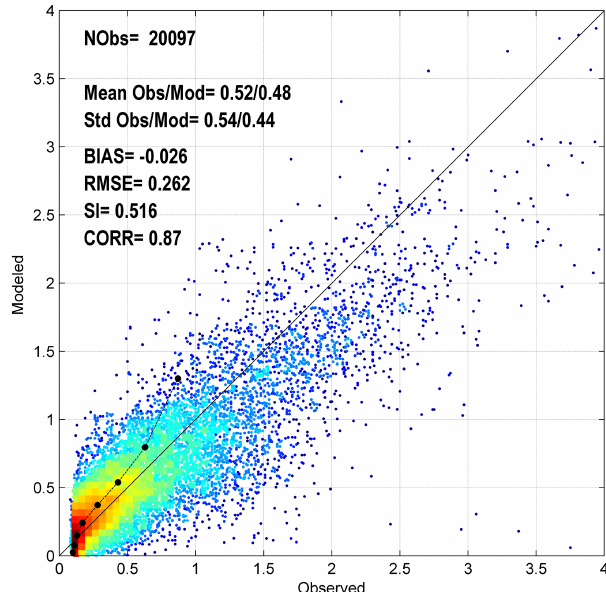
Figure 9. Quantile–quantile plot of observed and downscaled wave height.